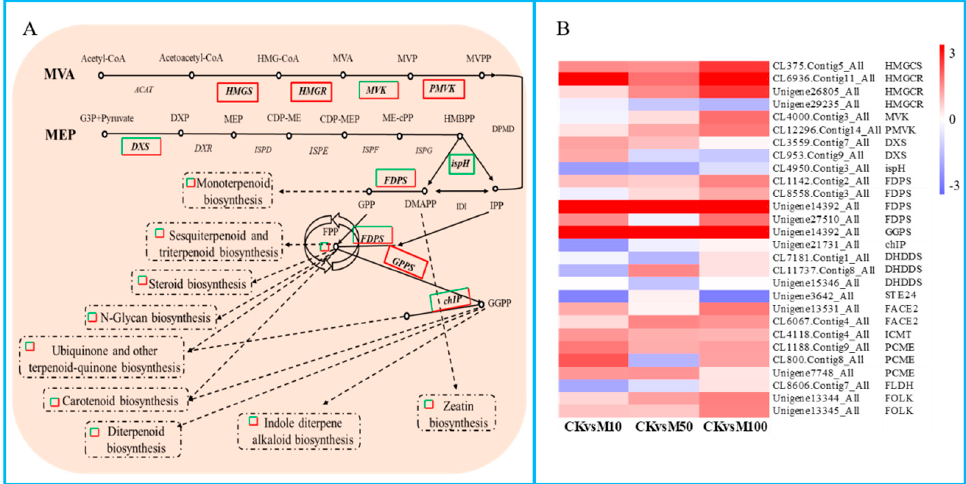
Figure 6. DEGs assigned to terpenoid biosynthesis pathway under MeJA treatments. ( A ) simplified diagram of the terpenoid biosynthesis pathway. ( B ) heat map of the expression of DEGs related to terpenoid backbone biosynthesis pathway.